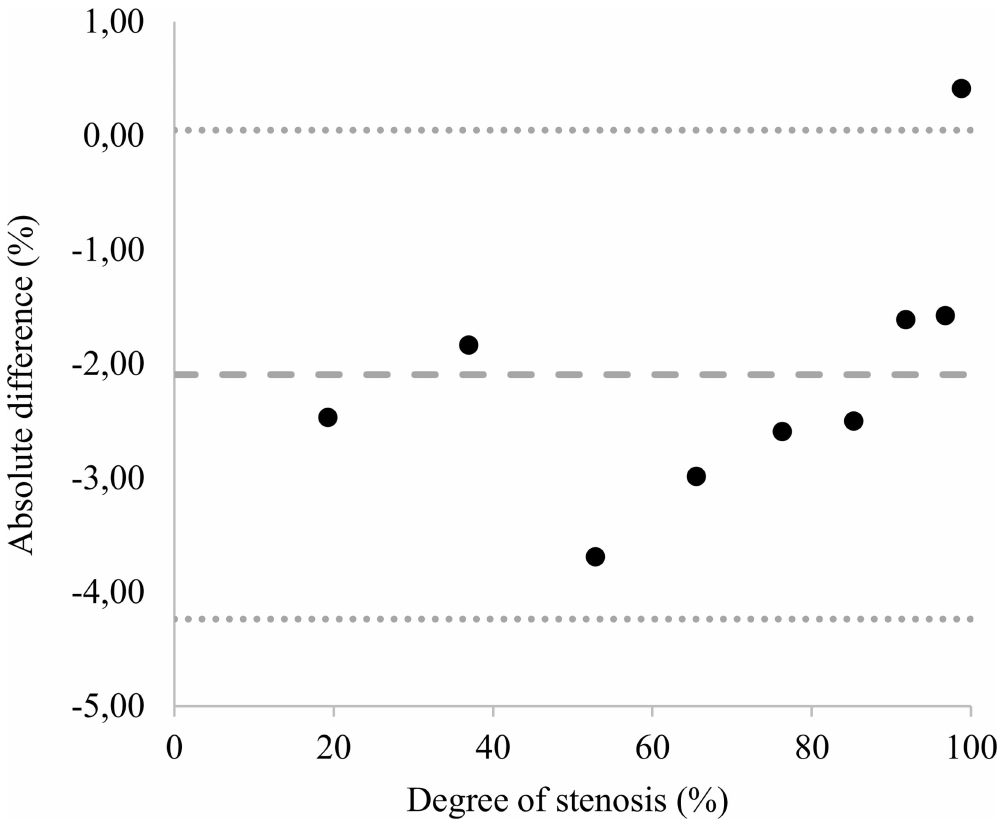
Fig 7. Bland-Altman plot of the difference of the calculated and the measuredstenosis of the stenosis phantoms. The mean absolutedifference is -2.09%. This indicatesthat there is a slight overestimation of the degreeof stenosis in comparison to the calculatedvalues. This overestimation decreases with increasingdegreeof stenosis becauseof the smaller diameters of the residual